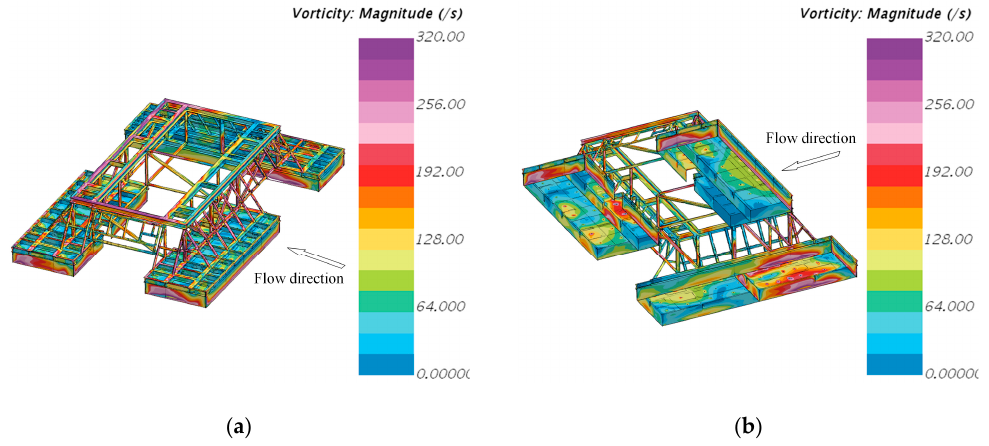
Figure 13. Vorticity visualization on the surface of the model in Case 5: ( a ) The top view of the flow field, ( b ) Lower view of the flow field.